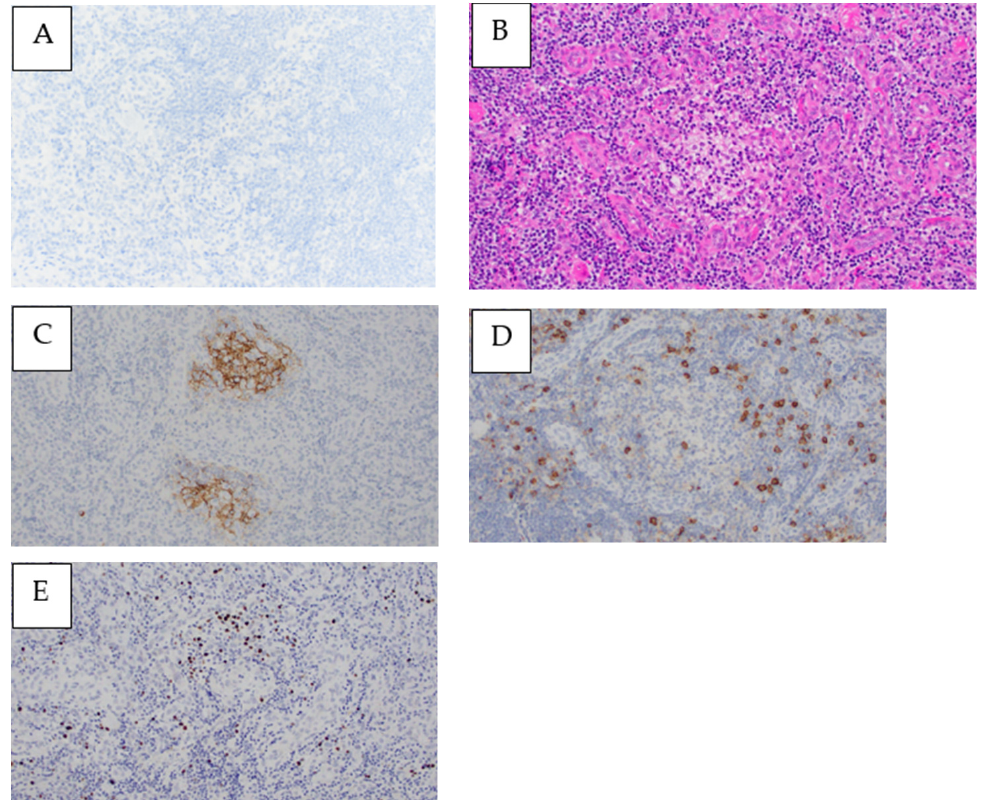
Figure 4. Inguinal lymph node biopsied on day 18 of admission. ( A ) Human herpesvirus-8 latency- associated nuclear antigen-1 (HHV-8 LANA-1) was negative in lymph node specimens. Magnification × 200; ( B ) hematoxylin and eosin staining demonstrating lymphoid follicles markedly atrophic, with a dense vascular proliferation of high endothelial venules between the follicles. Magnification × 200; ( C ) CD23 staining displaying barely visible lymphoid follicles, with a disorganized network of follicular dendritic cells extending beyond the pre-existing germinal center. Magnification × 200; ( D ) CD38 staining showing infiltration of positive plasma cells and small lymphocytes around blood vessels. Magnification × 200; ( E ) scattered cells were positive for Epstein–Barr virus-encoded RNA in situ hybridization (EBER-ISH). Magnification × 200.